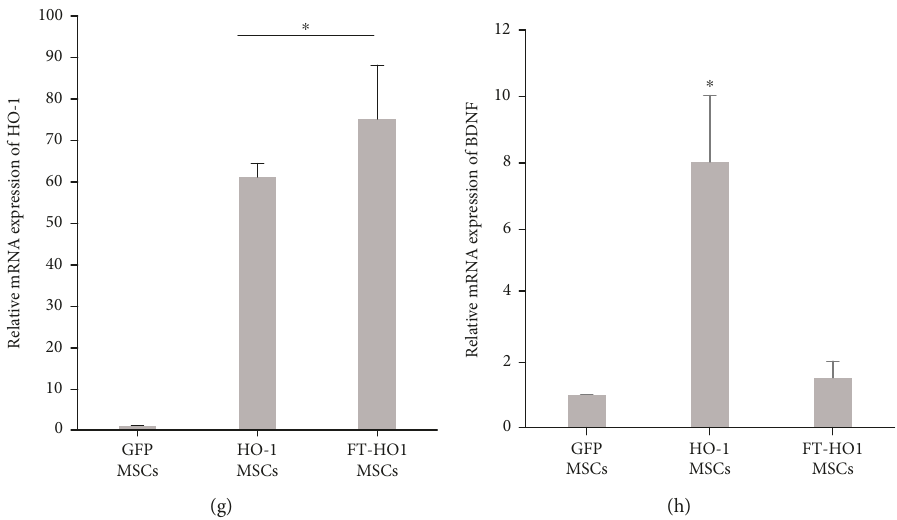
Figure 1: mRNA expression of factors (a) NANOG, (b) OCT-4, (c) SOX2, (d) IL-6, (e) TNF- α , (f) IL-10, (g) HO-1, and (h) BDNF. Each bar represents the average of four samples and error bars represent standard error. ∗ and # indicate signi fi cance at p ≤ 0 05